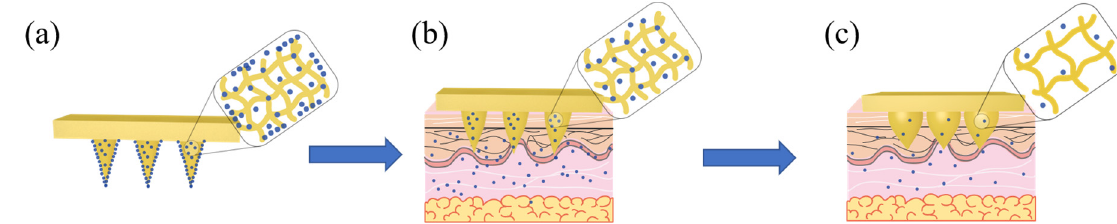
Figure 12. Release mechanism diagram of MT/SF@MNs: ( a ) schematic diagram of original microneedles, ( b ) schematic diagram of the early stage of microneedles, and ( c ) schematic diagram of the late stage of microneedles.